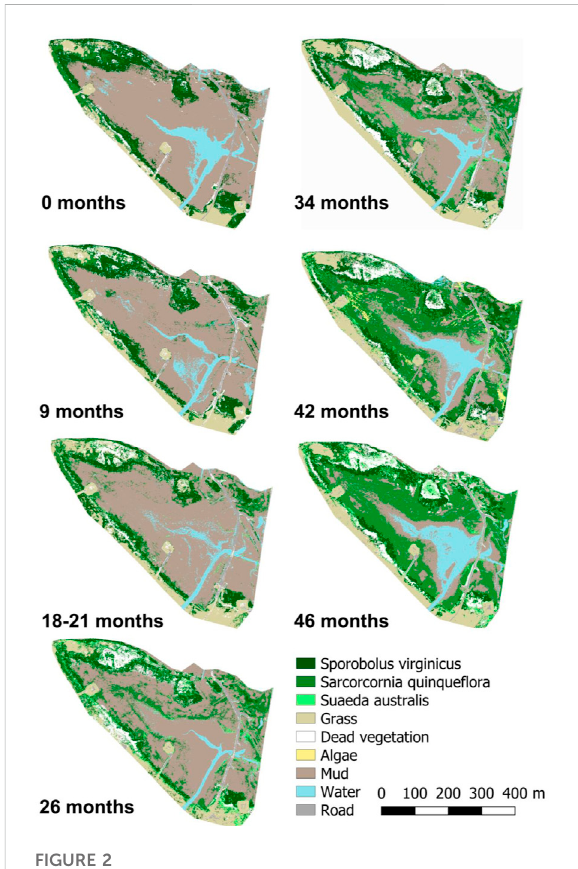
FIGURE 2 Classi fi ed drone images (0.1 m resolution) indicating land coverchangespostrehabilitation.Notethatwatercoverisvariable between images because the wetland is a dynamic system that experiences natural and synthetically mimicked (via automated fl oodgates; Sadat-Noori et al., 2021) variations in tidal inundation over multiple